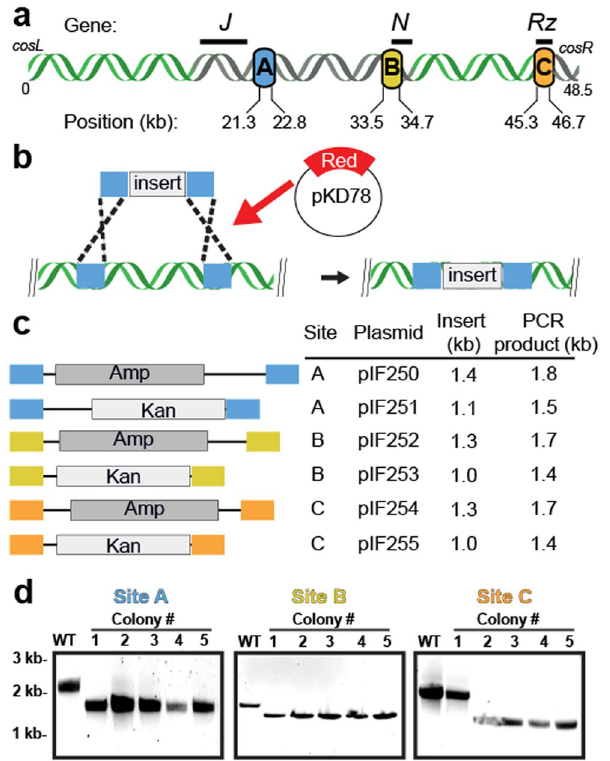
Figure 1. Recombineering at three unique positions within the λ -phage genome. ( a ) Insertion cassettes were designed for three sites targeting dispensable segments of the λ -phage genome (shown in gray). These cassettes are 21.3 kb, 33.5 kb and 45.3 kb away from cosL (designated A, B and C, respectively). ( b ) Schematic of the Red-based recombineering. An arabinose-inducible plasmid supplies the three Red genes. ( c ) Cassettes for efficient recombineering into each of the sites shown in ( a ). The cassettes carry an antibiotic resistance gene that is flanked on both sides by ~200 bp of homology to λ -DNA. ( d ) Recombineering efficiency was scored by colony PCR followed by agarose gels analysis. Successful recombineering generates a smaller PCR fragment. We observed 90–100% insertion efficiency at each of the three target